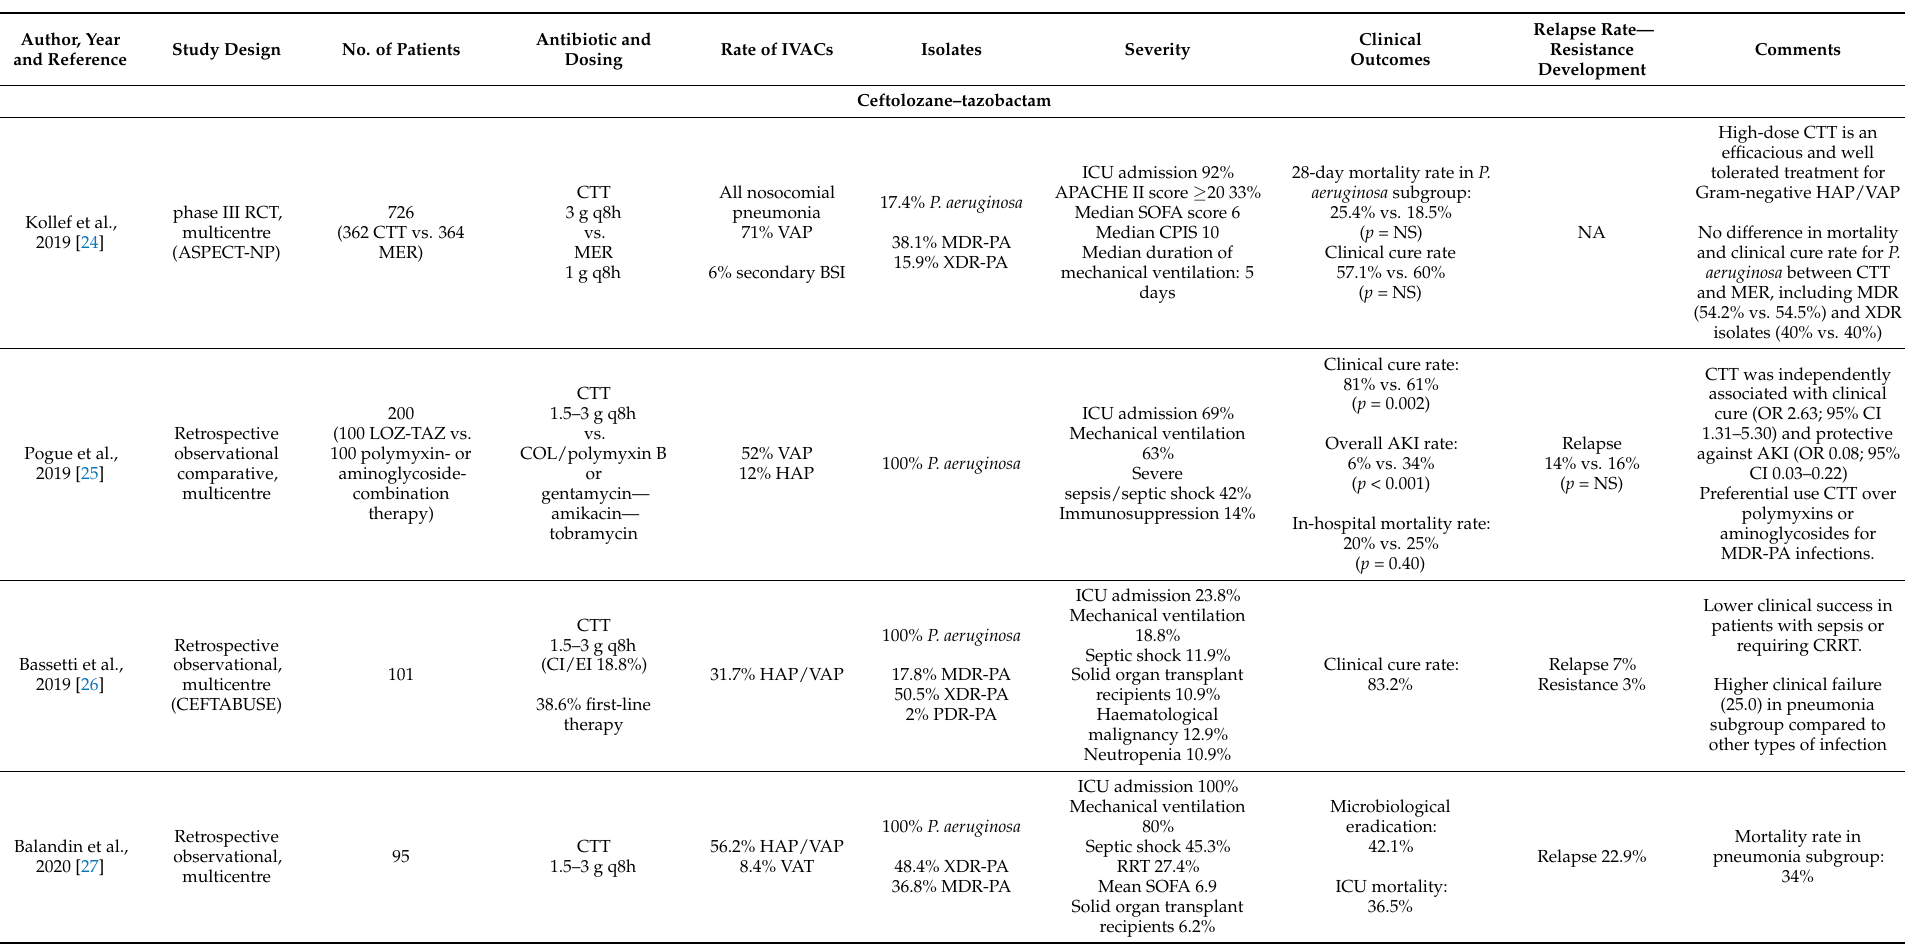
Table 2. Summary of the studies investigating the treatment of multidrug-resistant (MDR) metallo-beta-lactamase-negative GES-negative Pseudomonas